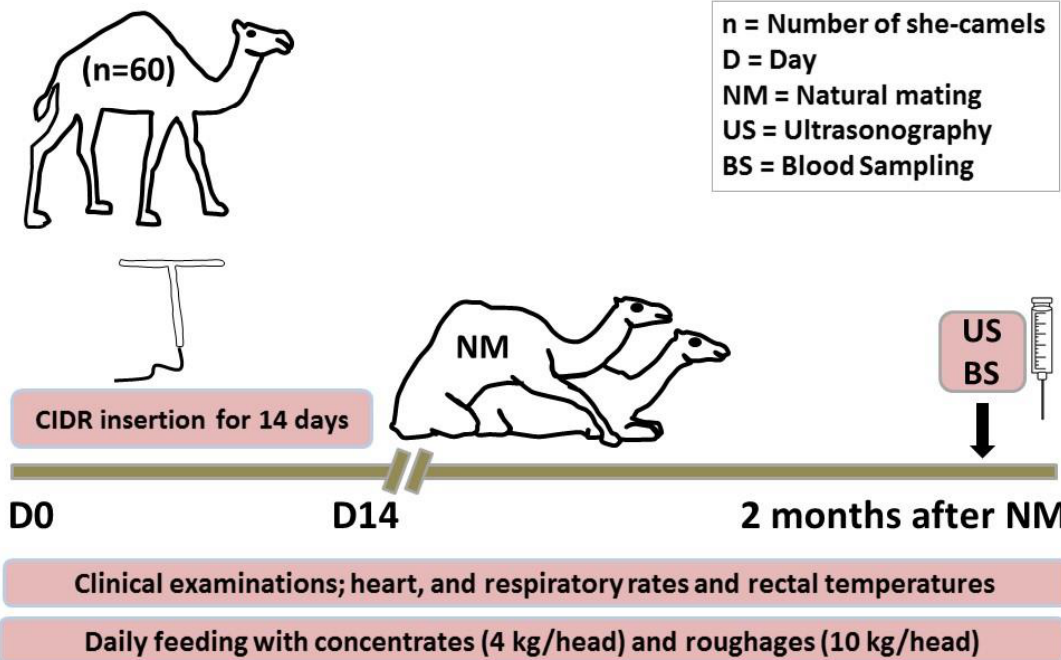
Figure 1. Schematic diagram showing the experimental protocol for the study. She-camels ( n = 60) were subjected to pre-synchronization using controlled-internal drug releasing (CIDR) for 14 days (D0: day of the insertion of CIDR). After removal of CIDR, pre-synchronized she-camels were subjected to natural mating (NM). In all naturally mated she-camels, ultrasonography (US) and blood sampling (BS) for further biochemical and hormonal assay were performed 2 months after NM. Clinical examinations including assessment of heart and respiratory rates and rectal temperatures were performed. Daily feeding with concentrates (4 kg/head) and roughages (10 kg/head).